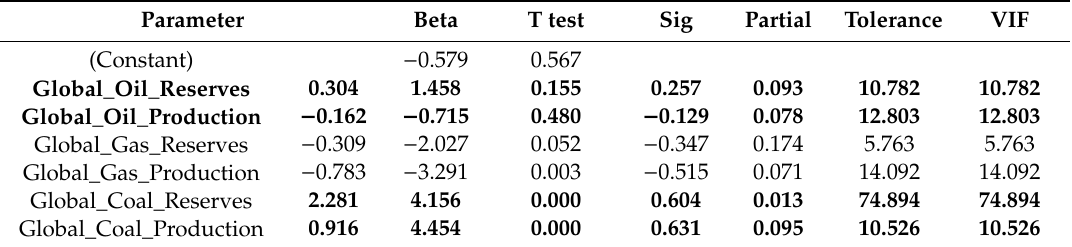
Table 3. Multicollinearity and partial correlation of the parameters from the Global Fuels group.